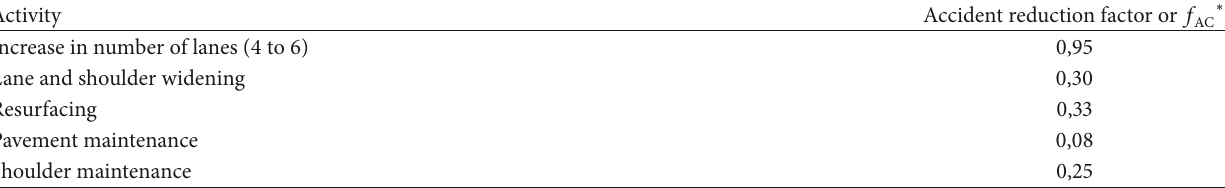
Table 4: Accident reduction factors for